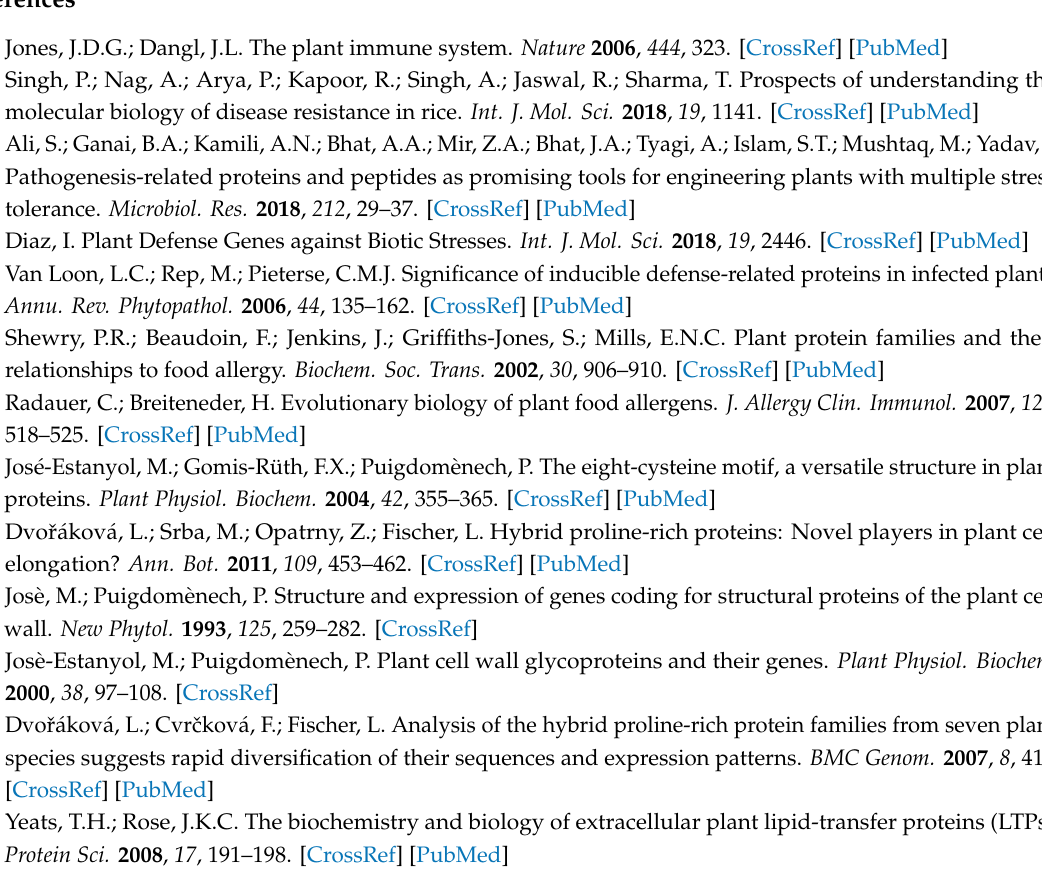
Figure S1: Collinear genes pairs of OsHyPRP genes on all 12 rice chromosomes. Red lines indicate segmental duplication of OsHyPRP genes on all 12 rice chromosomes and gray lines represent the collinear segments other than of OsHyPRP genes; Figure S2: Tandem and collinear pairs of duplicated OsHyPRP genes in rice genome as predicted through MCScanX; Figure S3: The intron-exon structure of OsHyPRP genes. The genomic coordinates of OsHyPRPs were used to draw the gene structure. The majority of genes were found to be intron-less; Table S1: List of cis -regulatory elements, their sequence, functions and number of elements identified in the 1.5 kb promoter region of four OsHyPRP genes; Table S2: The sequence of the primers used for qRT-PCR based expression